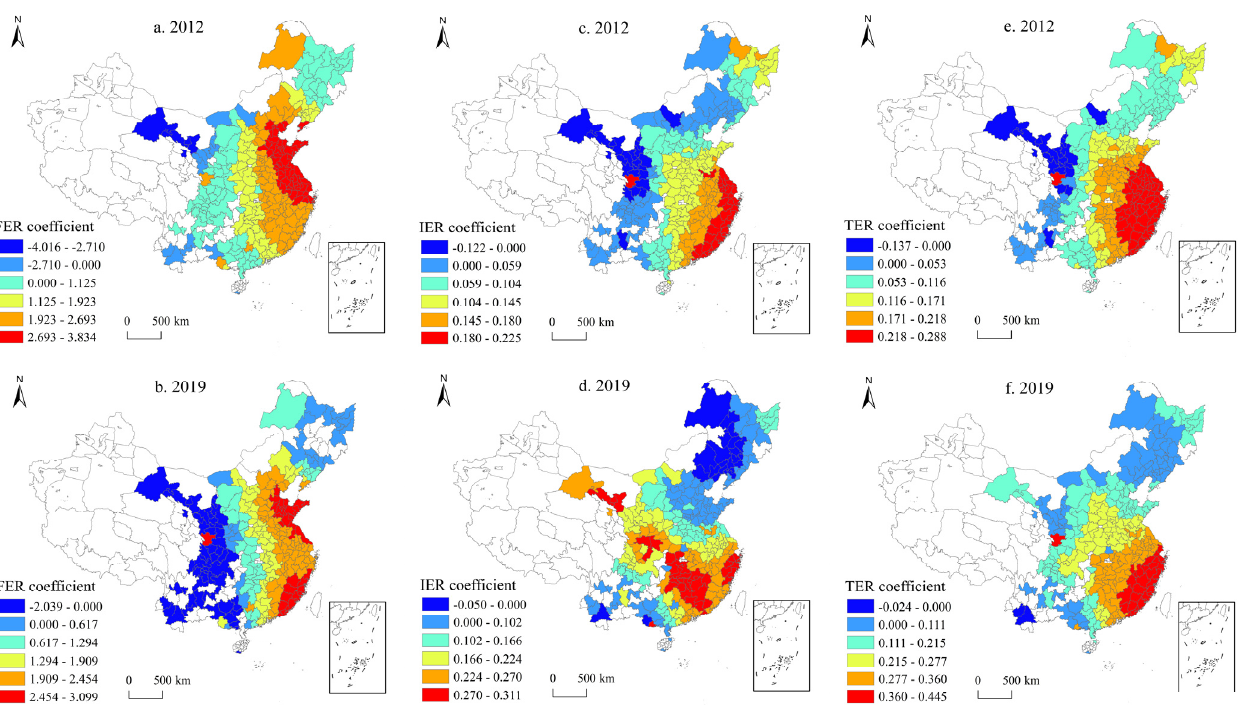
Figure 1. Regression results of GTWR. ( a ) Spatial distribution of FER coefficients in 2012; ( b ) Spatial distribution of FER coefficients in 2019; ( c ) Spatial distribution of IER coefficients in 2012; ( d ) Spatial distribution of IER coefficients in 2019; ( e ) Spatial distribution of TER coefficients in 2012; ( f ) Spatial distribution of TER coefficients in